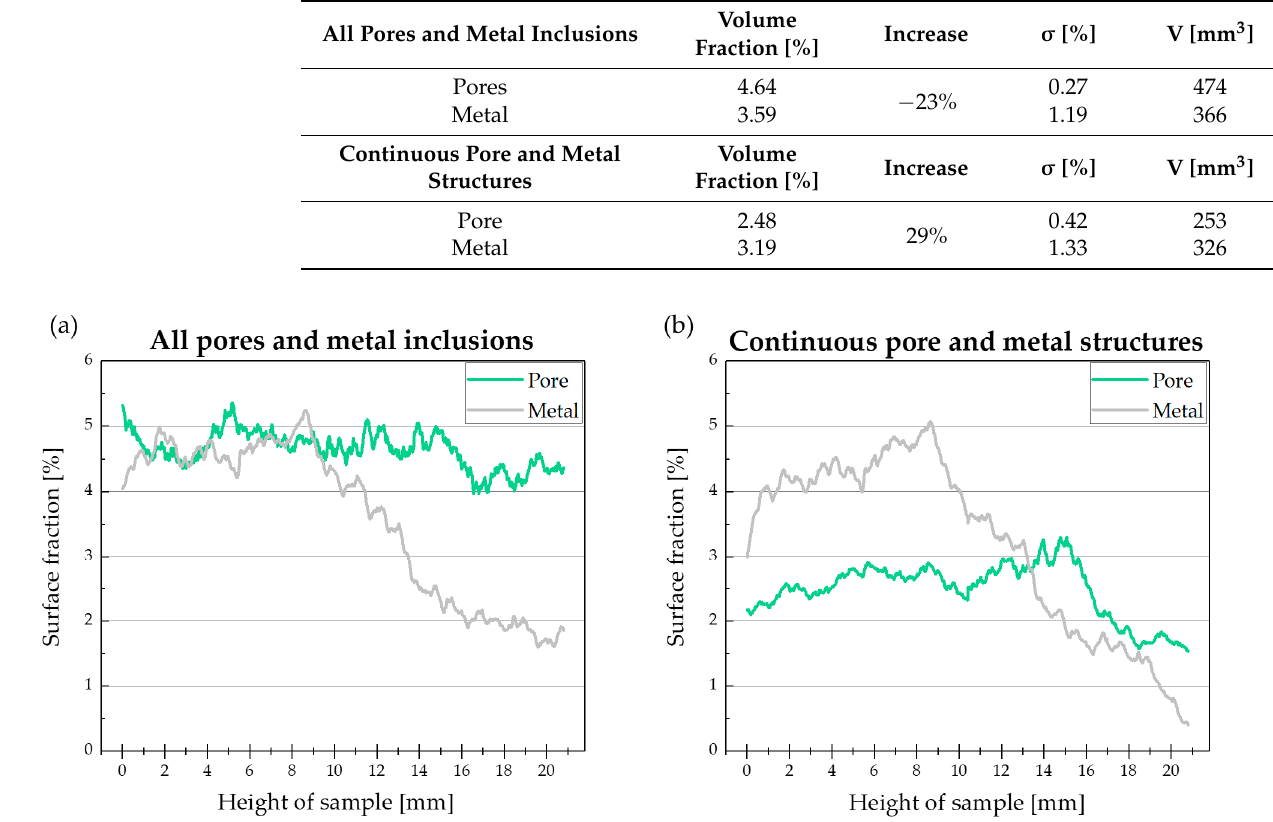
Figure 9. Surface fractions of pores and metal inclusions as a function of the sample height: ( a ) all pores and all metal inclusions and ( b ) continuous pore and metal structure.